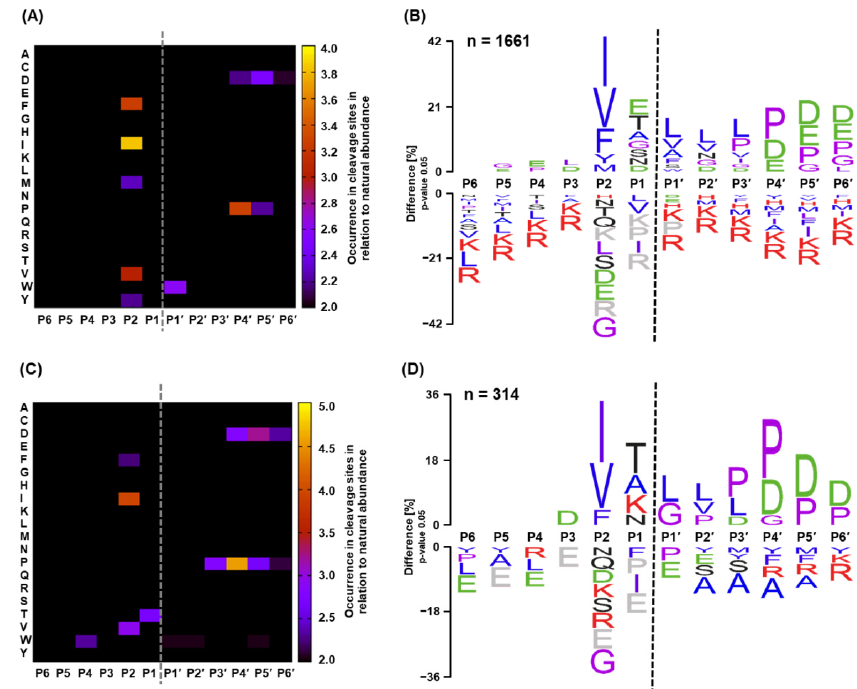
Figure 2. Identification of cleavage sites of SpeBm in peptide substrates derived from the E. coli proteome by PICS analysis. A cumulative number of 1975 unique cleavage events were determined in trypsin- ( A , B ) and GluC-derived ( C , D ) peptide libraries employing stable isotope labeling and HPLC-MS analysis. Heatmaps depict the fold-change in occurrence of specific amino acids at certain positions in the substrate in relation to their natural abundance using either ( A ) trypsin or ( C ) GluC as library protease. Sequence logos ( B , D ) demonstrate the difference in percent of amino acids at specific positions in prime and non-prime sites as obtained by the IceLogo algorithm. Data are based on ( C ) a tryptic or ( D ) a GluC-derived peptide library. The color code represents the physico-chemical properties of amino acids: hydrophobic residues (blue), positively charged residues (red), negatively charged residues (green), hydrophilic residues (black), and others (violet). Amino acids that were not found in any of the determined peptide substrates at a specific position are depicted in gray.